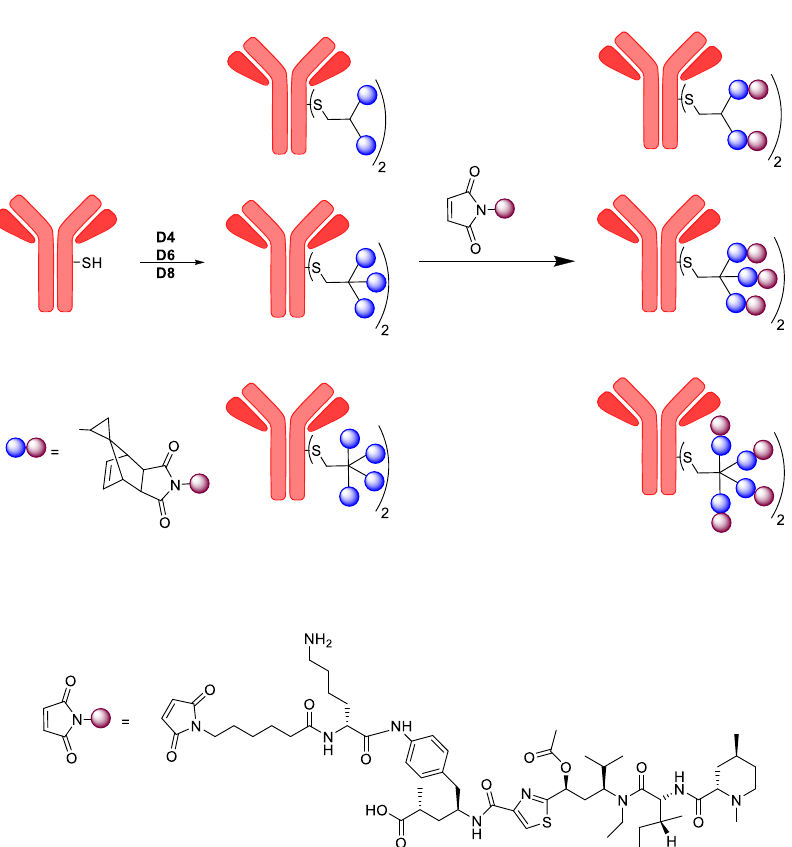
Figure 3. Preparation of DAR 4, 6 and 8 ADCs in a site-specific manner.